Question: State the chart type depicted above.
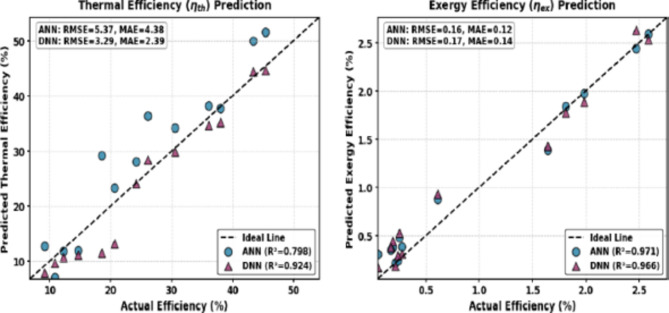
Answer: scatter